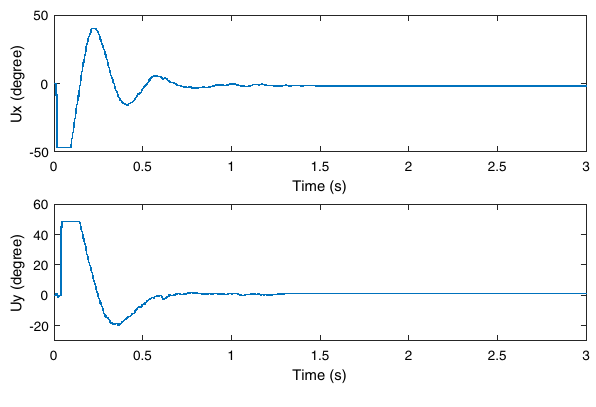
Fig. 8 The control input of